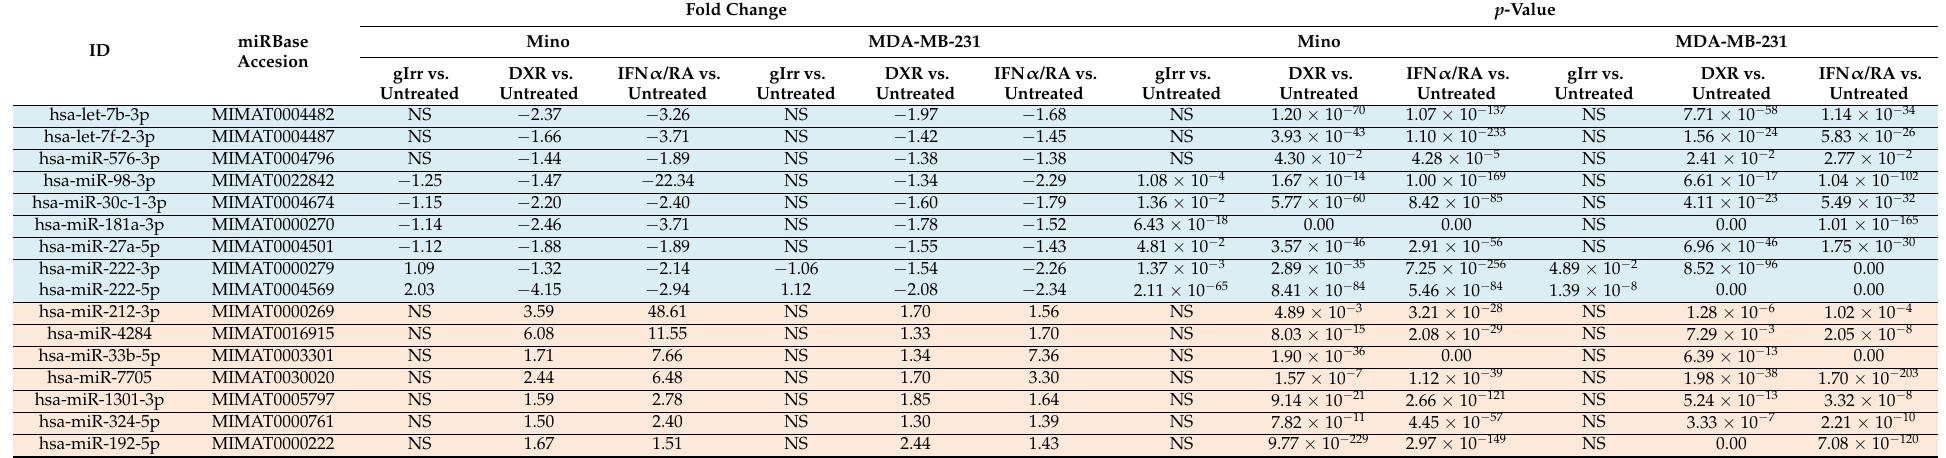
Table 1. Differentially expressed miRNAs in immunogenic cell death. miRNAs modulated by ICD inducers were identified through the selection of miRNAs whose expression was significantly different in DXR- or RA/IFN α -treated samples versus untreated ones ( p ≤ 0.05, FC ≤ − 1.3 for downregulated, FC ≥ 1.3 for upregulated), but not significantly different (NS) in gamma irradiation-treated samples. Downregulated miRNAs are highlighted in blue, upregulated miRNAs are highlighted in